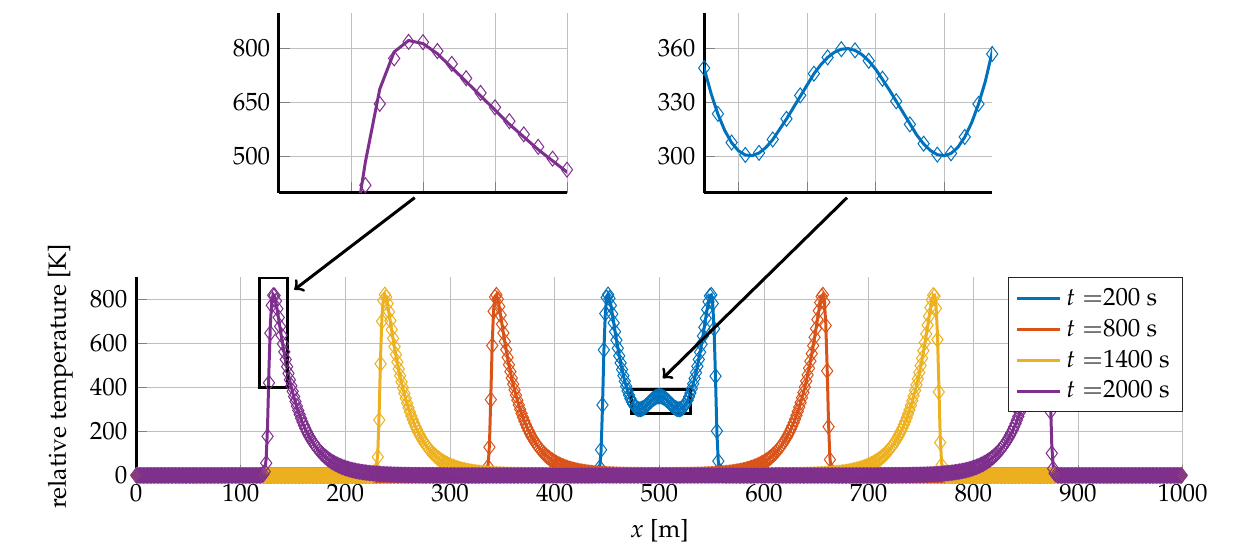
Figure 12. Solution of the temperature for the FOM (solid lines) and sPOD-sDEIM ROM (diamonds) at different time instances with Arrhenius coefficient β = 540K.